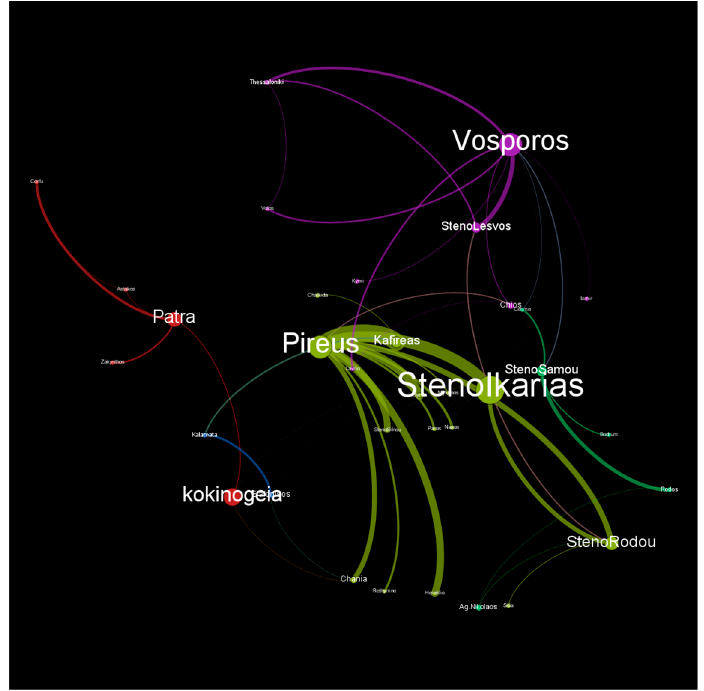
Figure 15. SNA of real ship transportation data for a given day (27/09/2018) in the Aegean Sea. Nodes are sized according to the betweenness centrality metric and colored according to their modularity class. Edges are weighted according to the number of ships passing between the nodes. Algorithms 2019 , 12 , 27